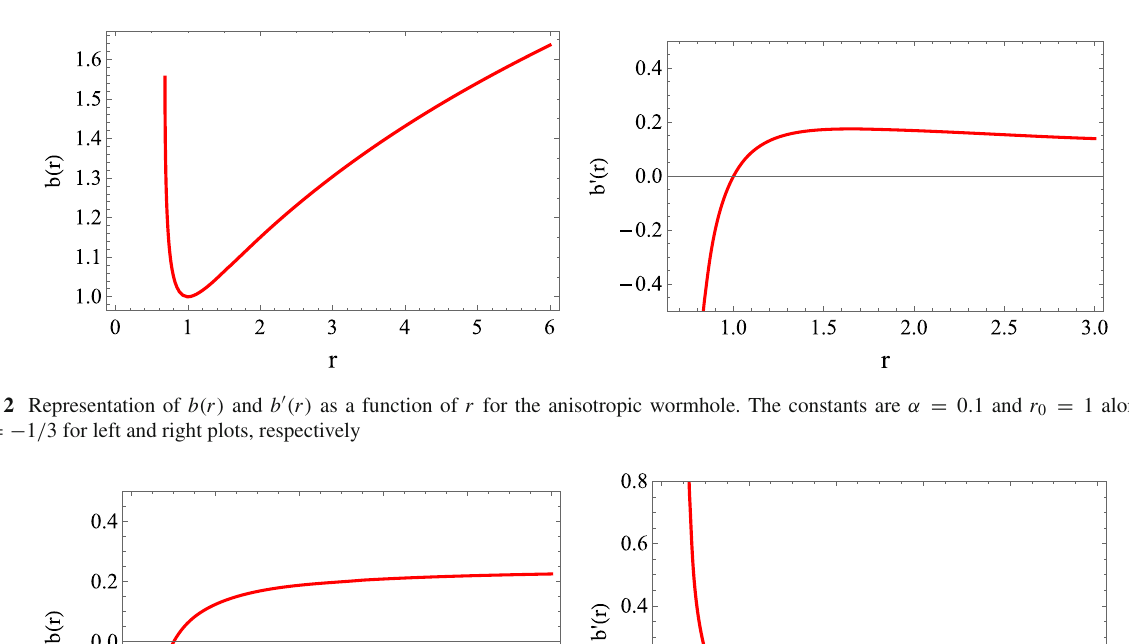
Fig. 1 Plots for b ( r ) and b (cid:7) ( r ) as a function of r for our exact isotropic wormhole. The constants are α = 0 . 1, ω = 0 . 5 and r 0 = 1 for the left and right plots, respectively